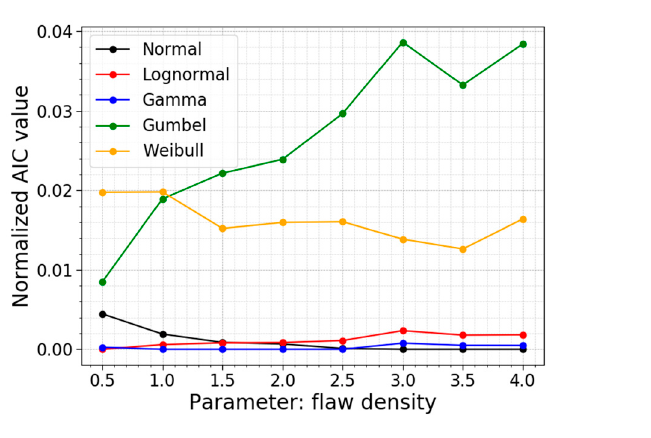
Figure 21. ( a ) PDF and ( b ) CDF for a varying flaw density.